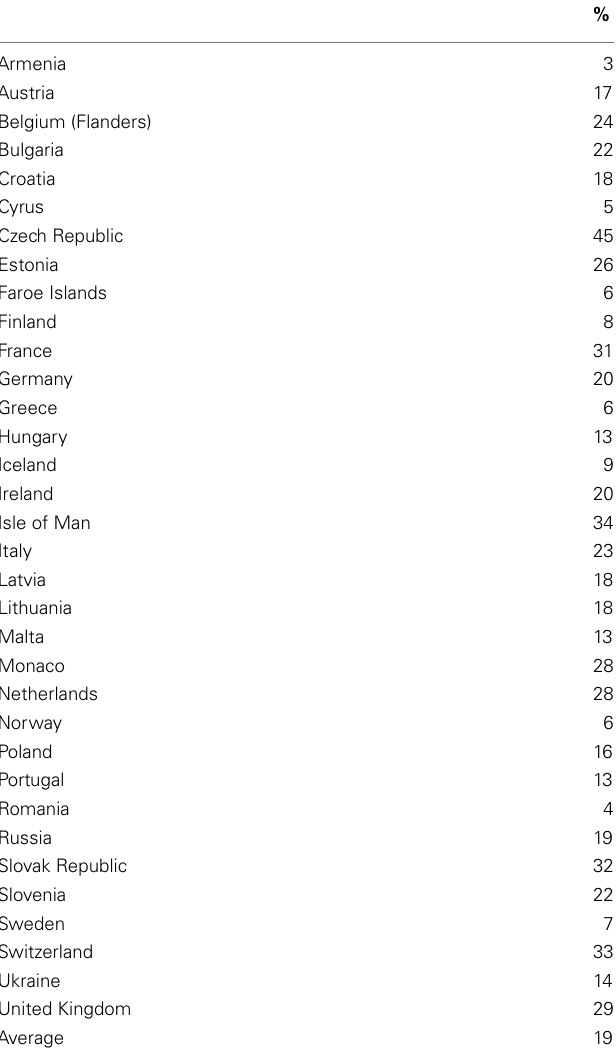
Table 1 | Life-time use of marijuana: 2007 ESPAD (18) (15–16year